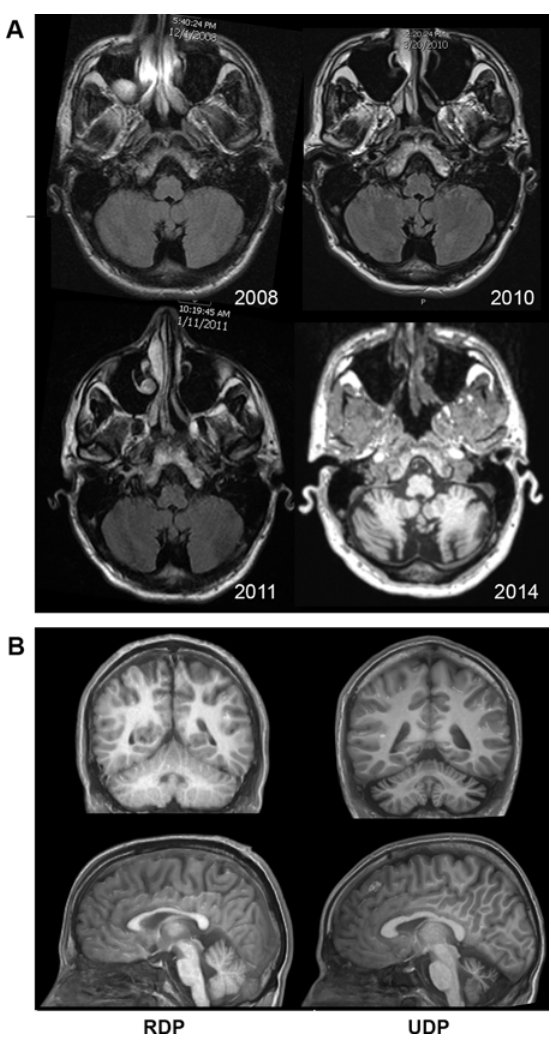
Fig 1. Sequential and comparative MRI. (A) Axial T1-weighted images from successive MRI scans acquired from 2008 (year of onset) to 2014 demonstrate the progressive development of cerebellar atrophy. (B) Coronal (top row) and sagittal (bottom row) T1-weighted images from MRI demonstrate relatively normal cerebellar structure and volume of a representative RDP patient (left images) in contrast to marked cerebellar atrophy of the patient in 2014 (right